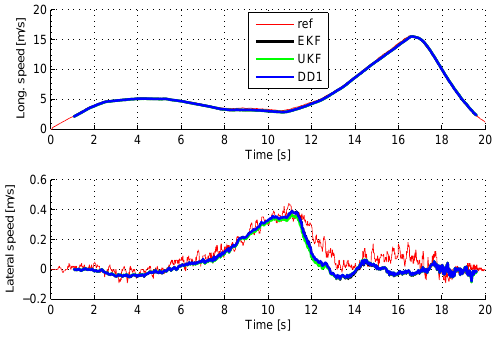
Figure 3. Longitudinal and lateral speed estimates during an emergency